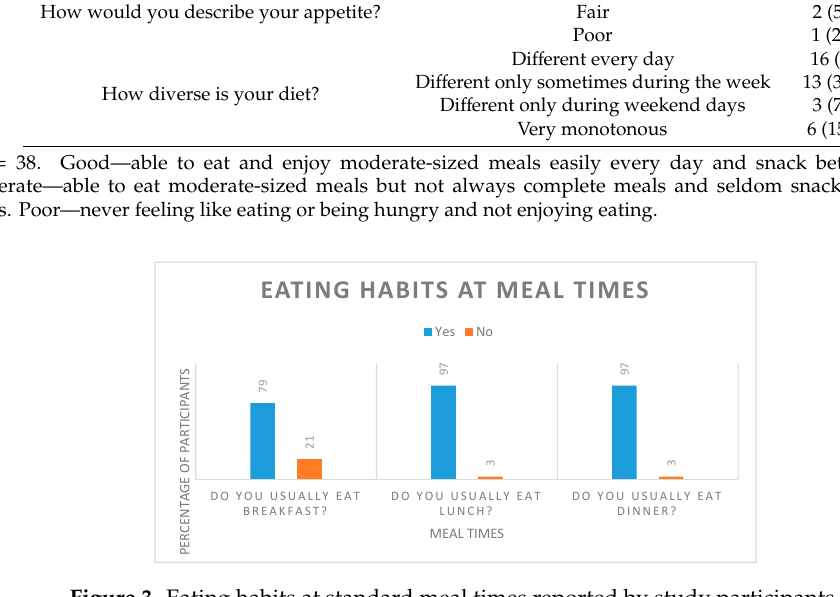
Table 7. General eating habits of the study participants.